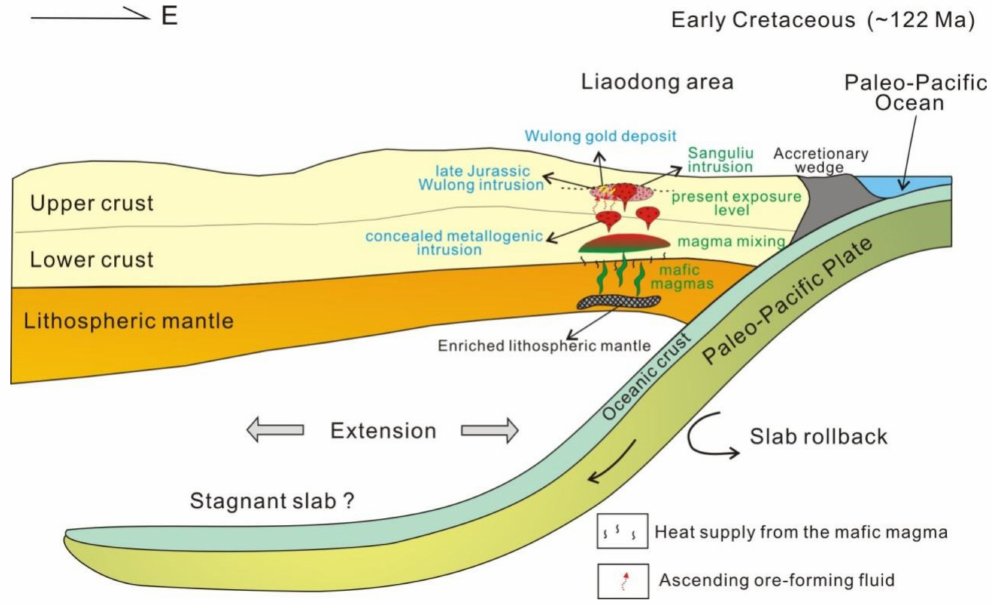
Figure 13. Schematic model for the Wulong gold mineralization and its links with the Early Creta- ceous magma mixing in the Liaodong Peninsula. The tectonic setting for the Liaodong Peninsula during the Early Cretaceous is from